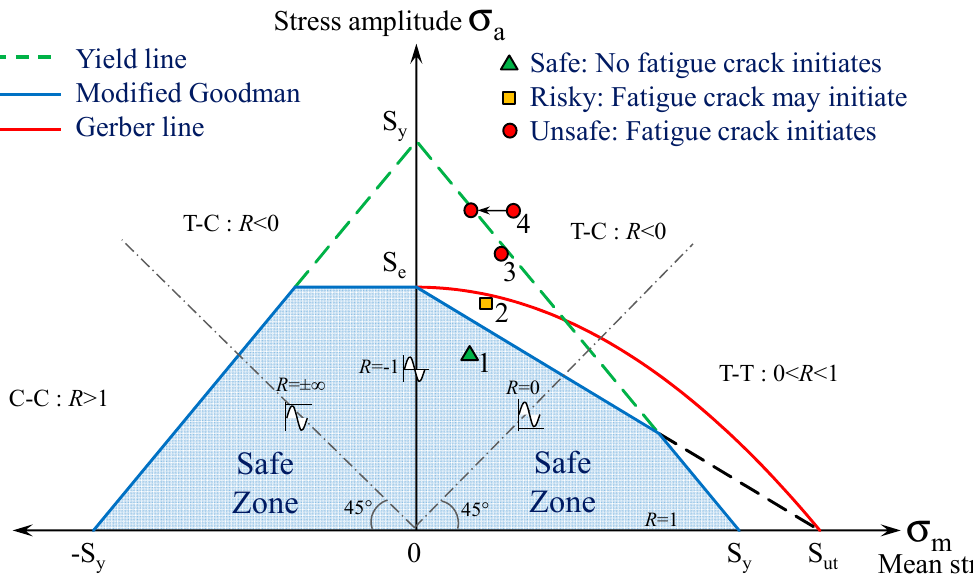
Figure 3. Illustration of different fatigue failure zones in the constant life diagram (CLD) approach.